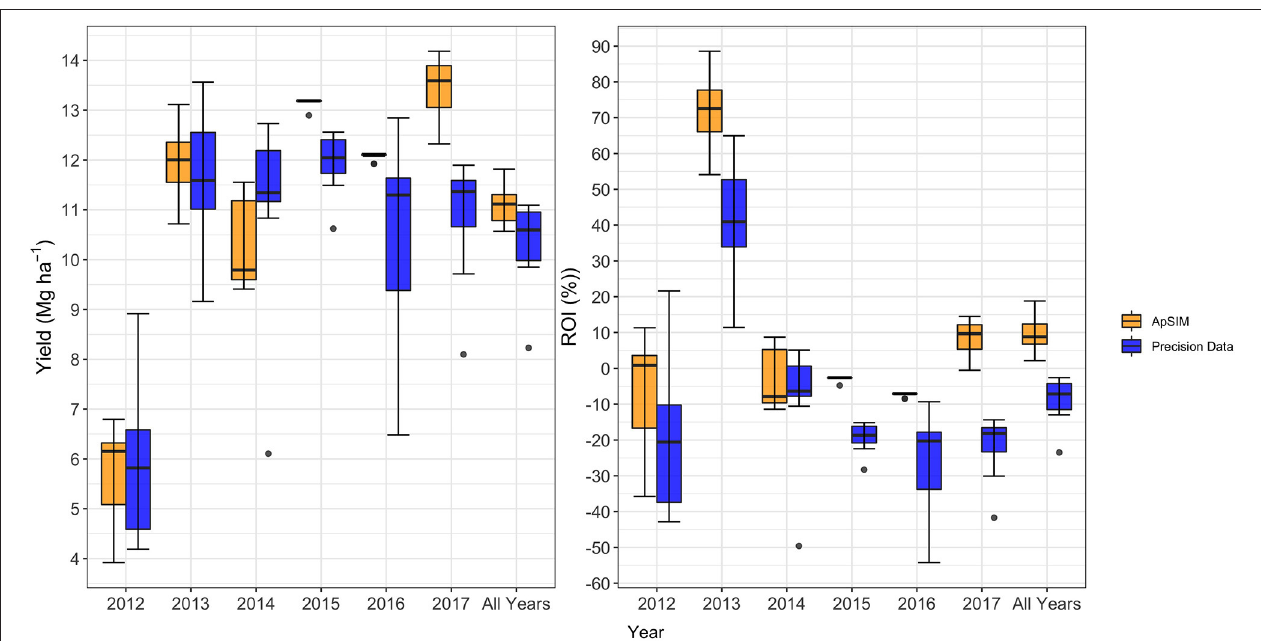
FIGURE 4 | Distribution of annual modeled and observed yield monitor data for each year of analysis. Filled boxes represent the interquartile range (IQR), end caps represent maximum and minimum and dots are outliers defined as > 1.5 times the IQR.